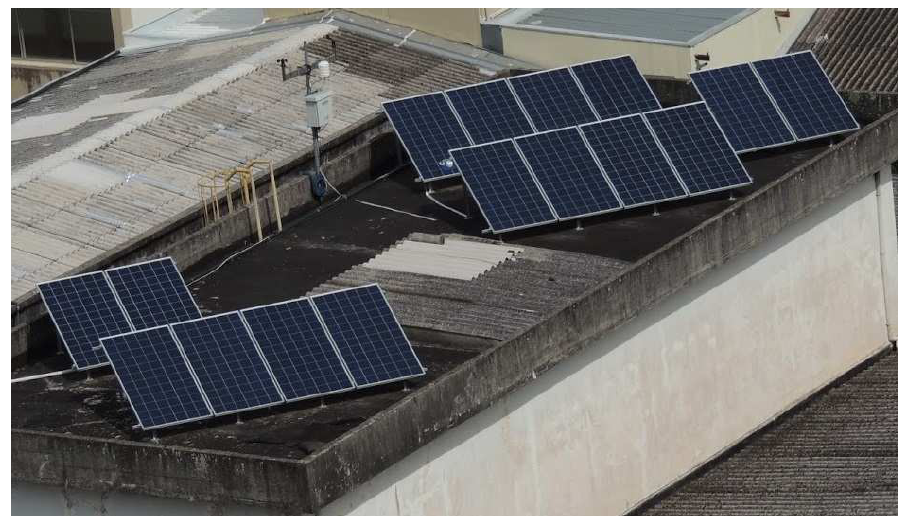
Figure 3. View of PV plant located at − 25.438686 (Latitude) and − 49.268487 (Longitude)–City of Figure 3: The proposed method consists in transmitting a frame using ⌈ α n cha ⌉ channel uses for the fi rst Curitiba–State of transmission attempt, with 0 < α ≤ 1 . In the event of a decoding error, incremental redundancy is transmitted 1 − α n cha ⌋ channel uses. making use of the rest of the available ⌊ ( )